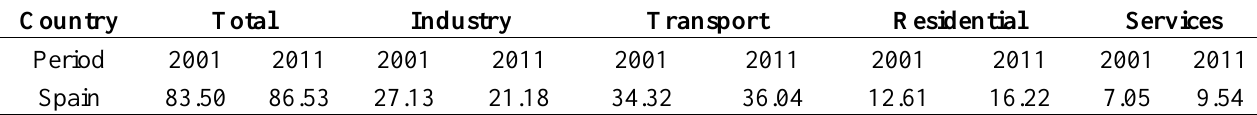
Table 1. Final energy consumption by sector in Spain (Mtoe) [1].